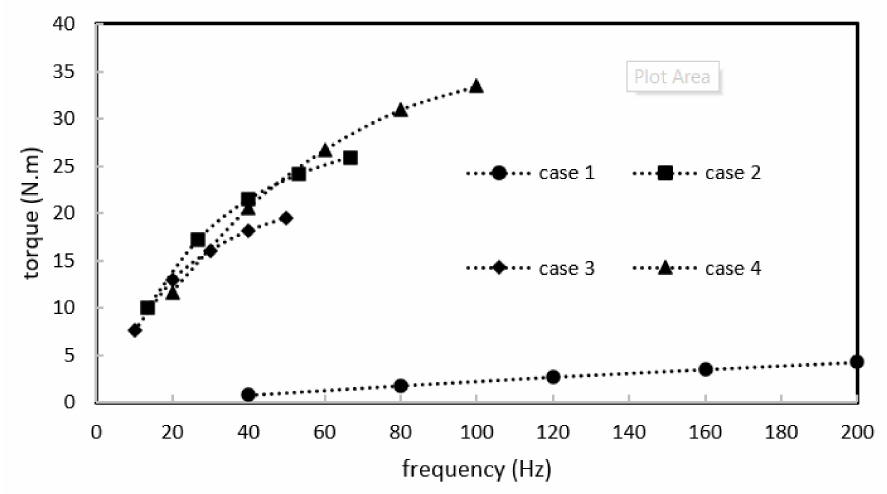
Figure 14. Torque changes at different frequencies.